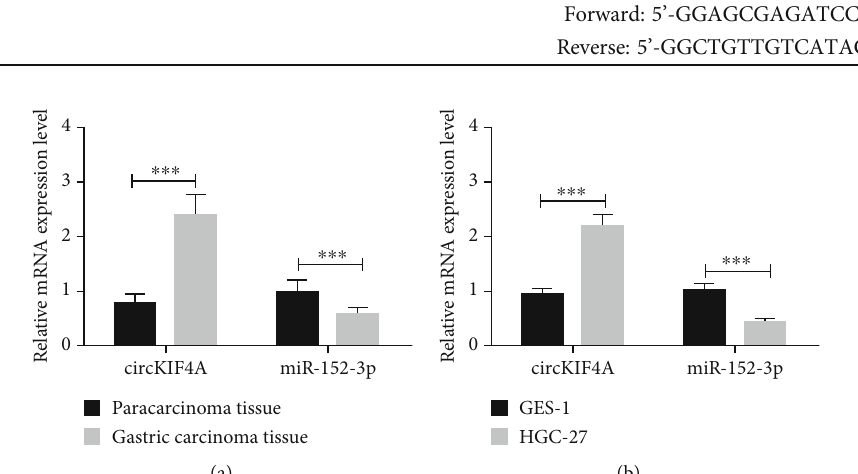
Figure 1: circKIF4A and miR-152-3p levels. a: circKIF4A and miR-152-3p expression in GC. b: circKIF4A and miR-152-3p expression in GC cells. ∗∗∗ P <